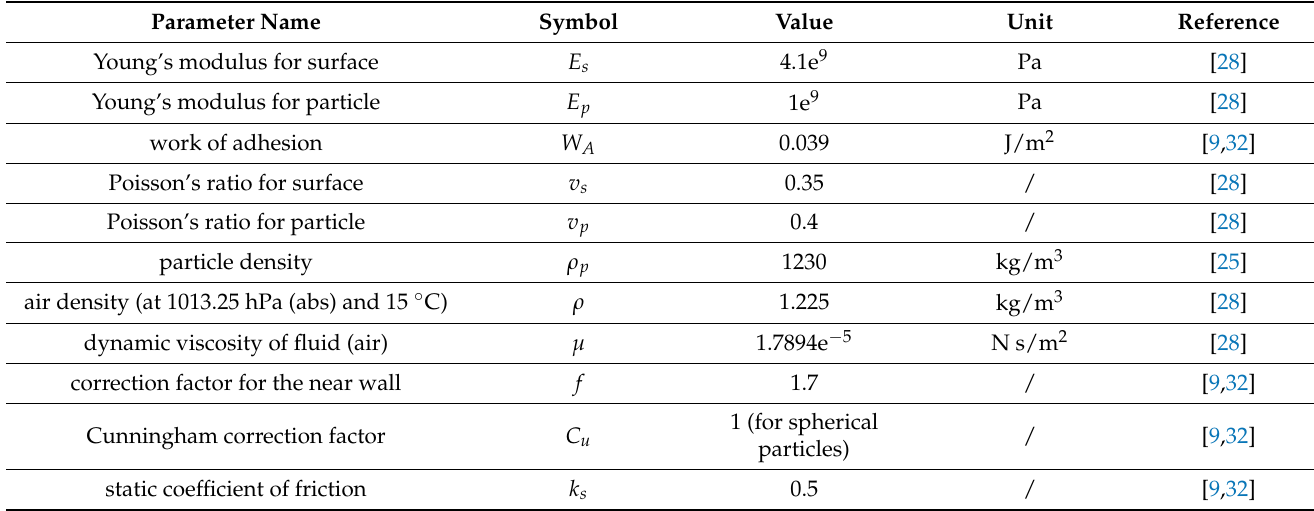
Table 1. List of constants used to define particle sticking behavior.